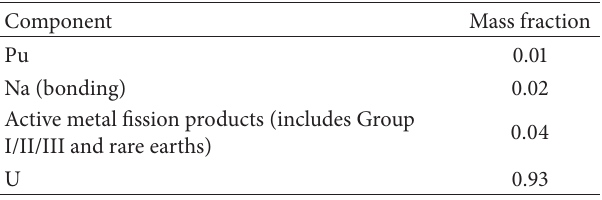
Table 2: Nominal composition of sodium-bonded metal used fuel.